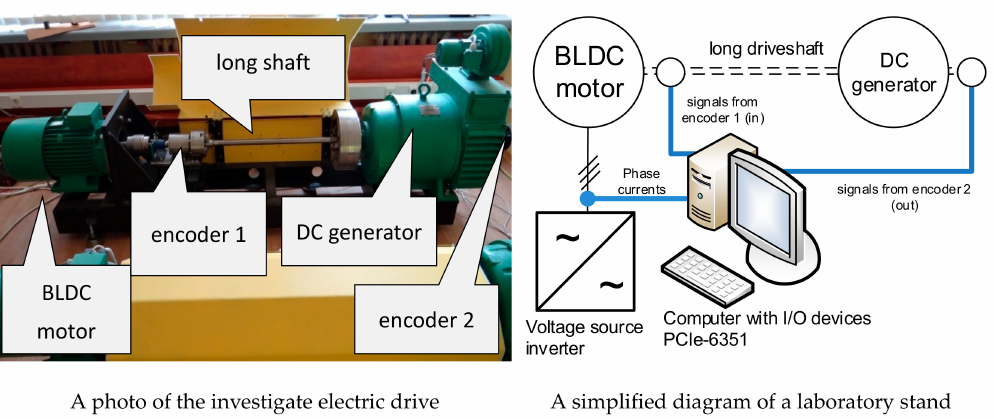
Figure 7. Stand for testing a drive system with elastic coupling.